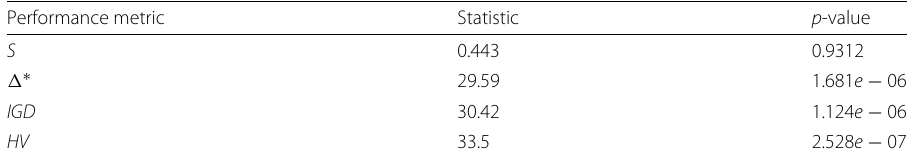
Table 10 Statistics and related p -values for the Friedman aligned omnibus test for each of the four performance metrics Performance metric Statistic p -value 0.443